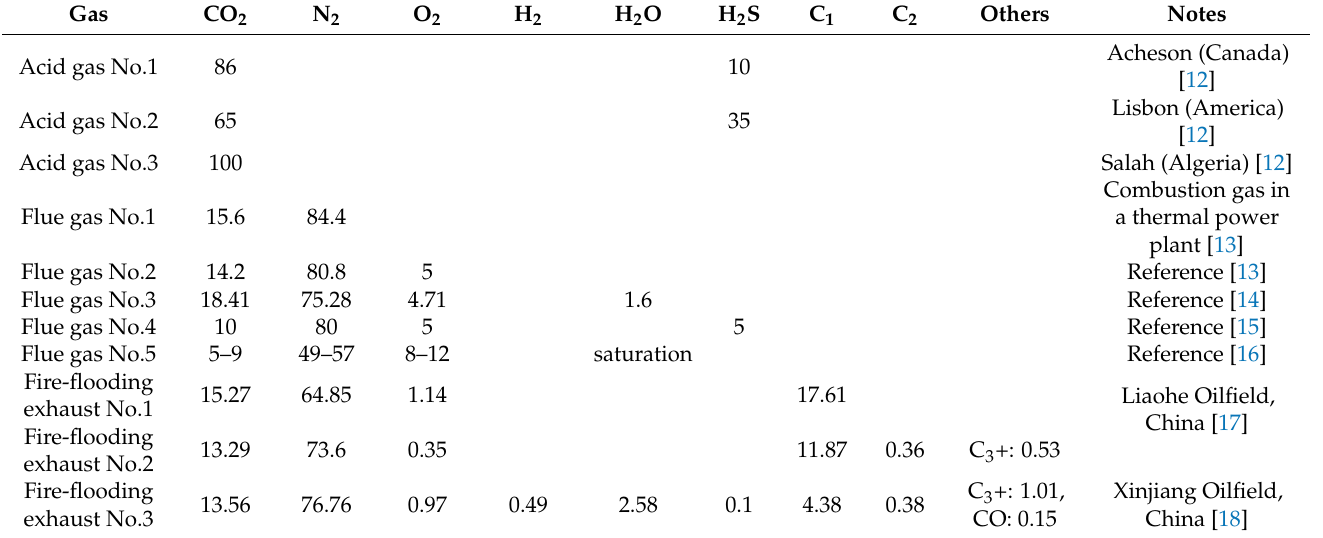
Table 1. Comparison of the components of acid gas, flue gas, and fire-flooding exhaust (unit: mol